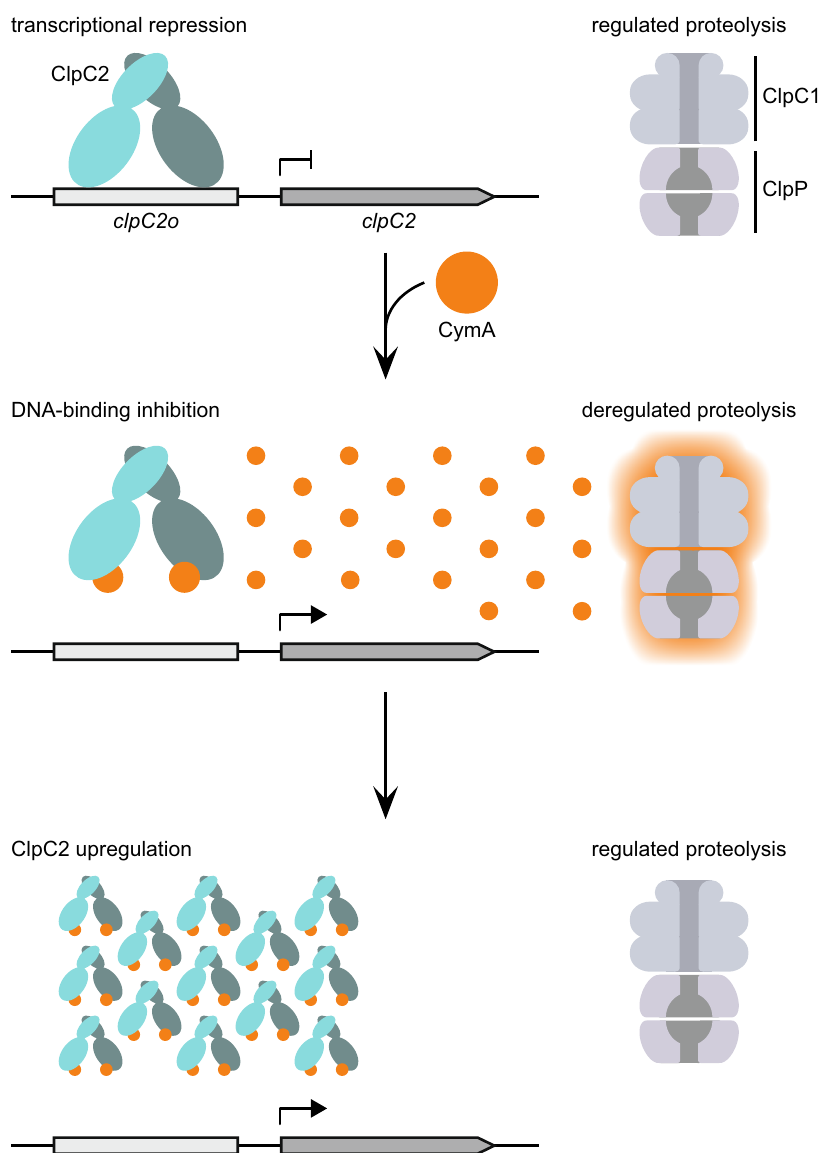
Fig. 6 ClpC2 response to CymA exposure helps protect mycobacteria from CymA-induced toxicity. ClpC2 binds to its own operator site ( clpC2o ) performing the role of a transcriptional repressor under standard growth conditions. Upon exposure to CymA, both ClpC1 and ClpC2 bind CymA leading to both aberrant ClpC1P activity as well as the lifting of clpC2 gene repression resulting in the upregulation of ClpC2. The increased ClpC2 protein levels bind the available CymA, preventing the toxic consequences of CymA interaction with